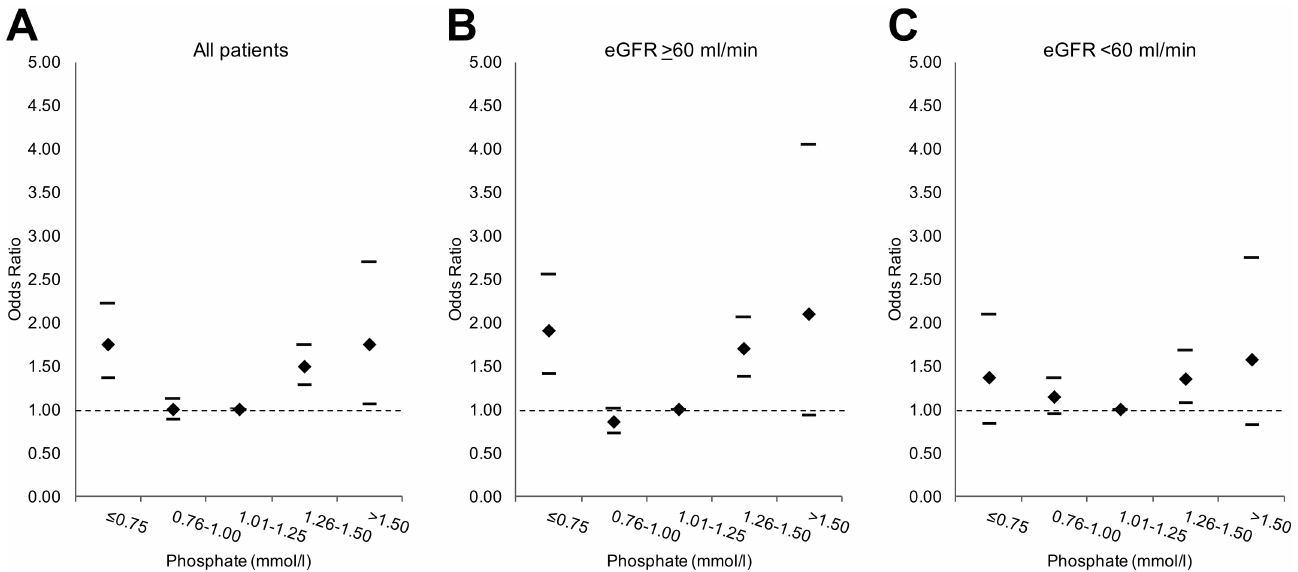
Fig 2. Odds ratio of composite cardiac outcome by serum phosphate at five-yearreview for all patients (n = 59880)(A), patients with eGFR > 60 ml/min (n = 39039)(B) and patients with eGFR < 60 ml/min (n = 20841)(C). The 95% confidenceintervalsare shown. The dotted lines identify an odds ratio of 1.00 in each